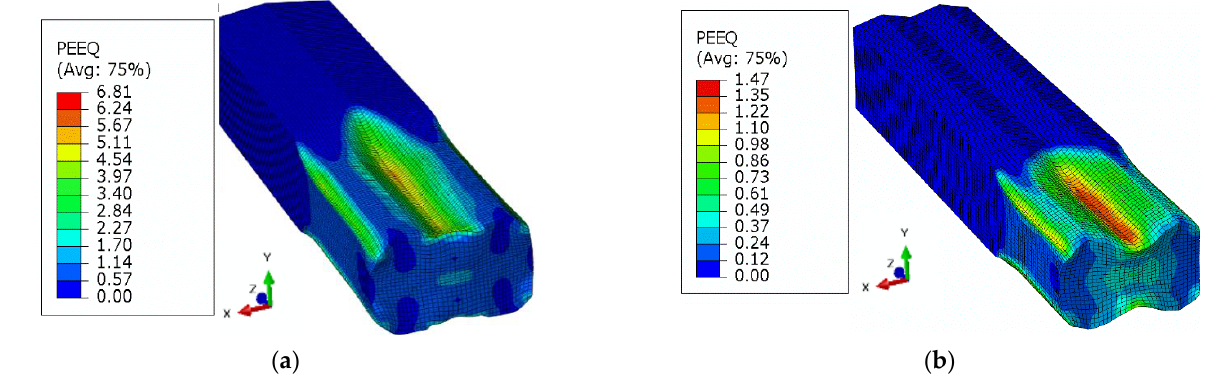
Figure 17. Equivalent plastic strain (PEEQ) distribution: ( a ) single barrel, ( b ) double barrel.